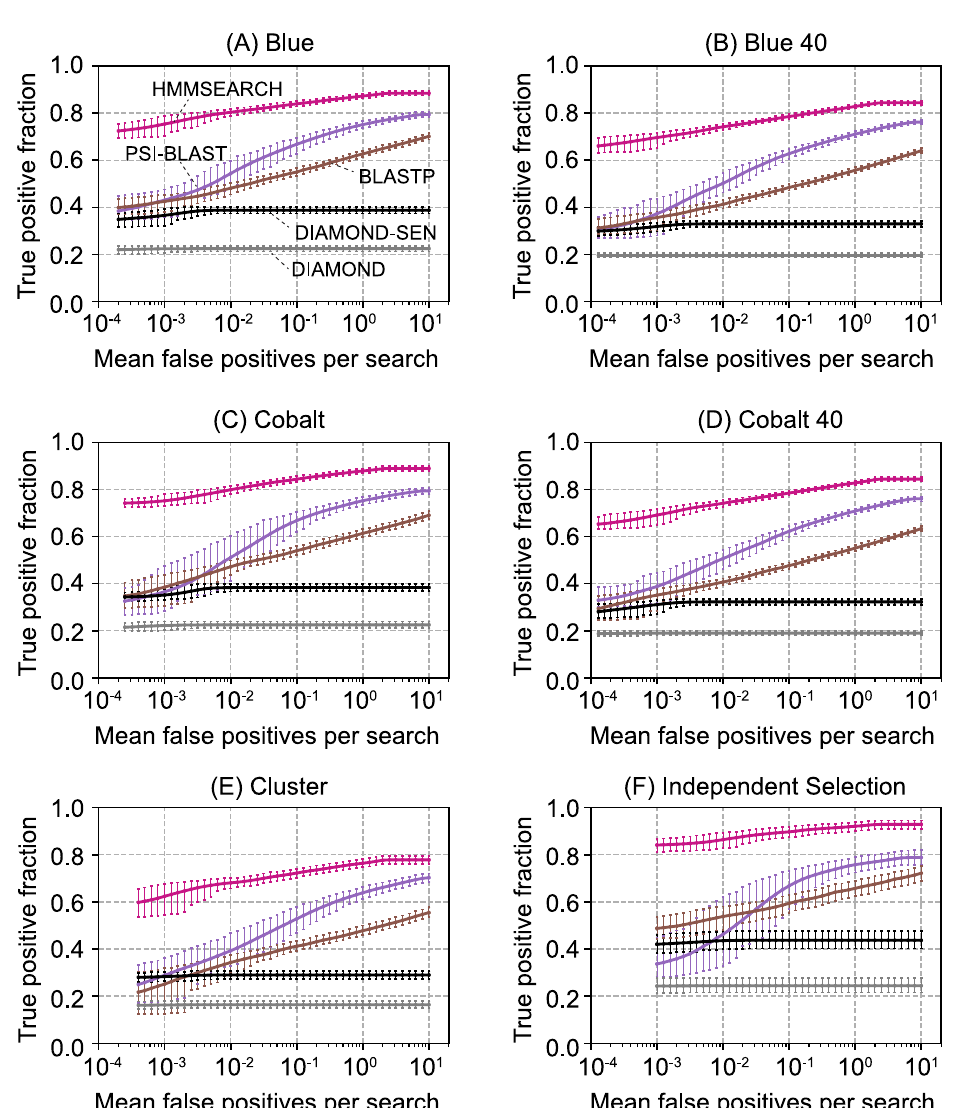
Fig 5. Homology search benchmarks on data produced by splitting algorithms. The benchmarks are constructed as in Fig 4. Blue 40 and Cobalt 40 refer to the algorithms run with the “best-of-40” feature. BLASTP and DIAMOND are benchmarked using family pairwise